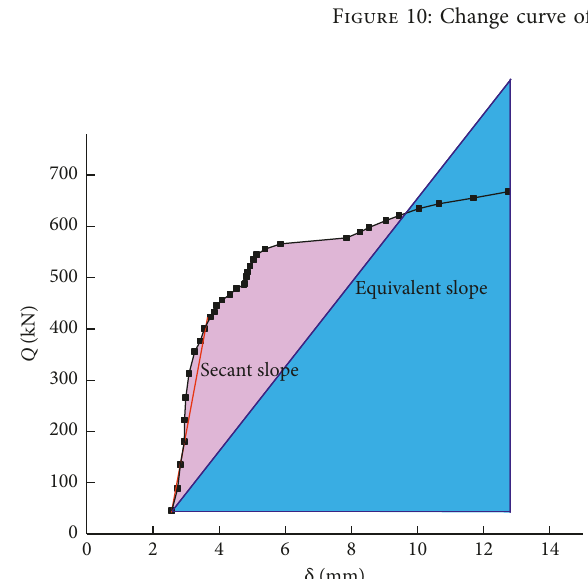
Figure 11: Relation curve of Q - δ